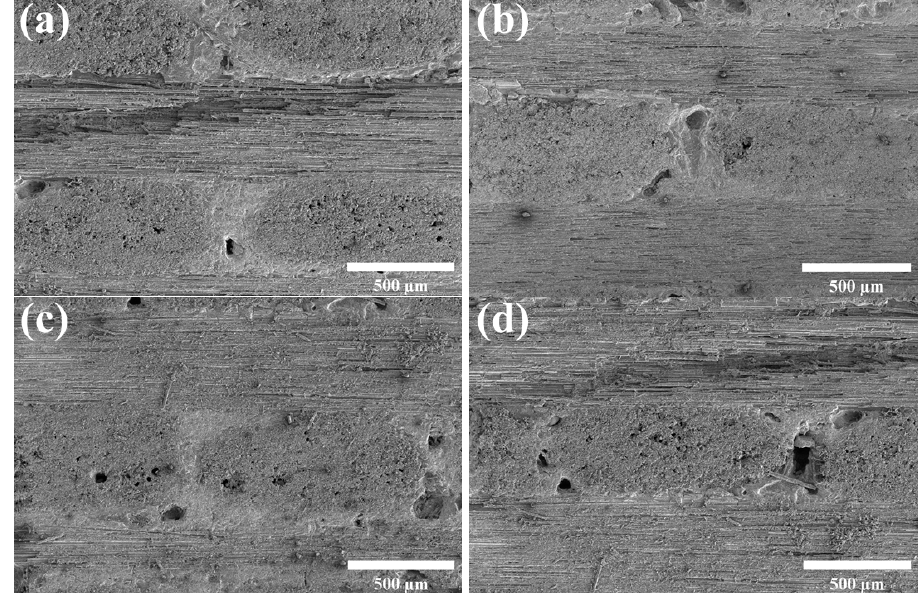
Fig. 10 Microstructures of C pf /SiC composites obtained with different resin carbon contents: (a) 2C#, (b) 4C#, (c) 6C#, and (d)